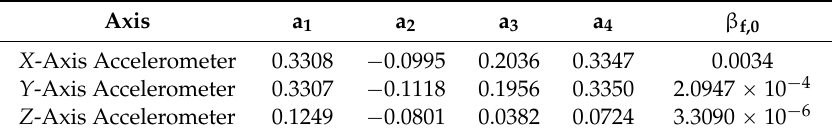
Table 4. Fourth order AR model coefficients of the three-axe accelerometer.